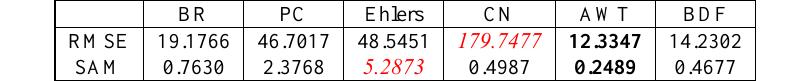
Table 8. RMSE and SAM (radian) between Worldview-2 multispectral and fused images using different algorithms